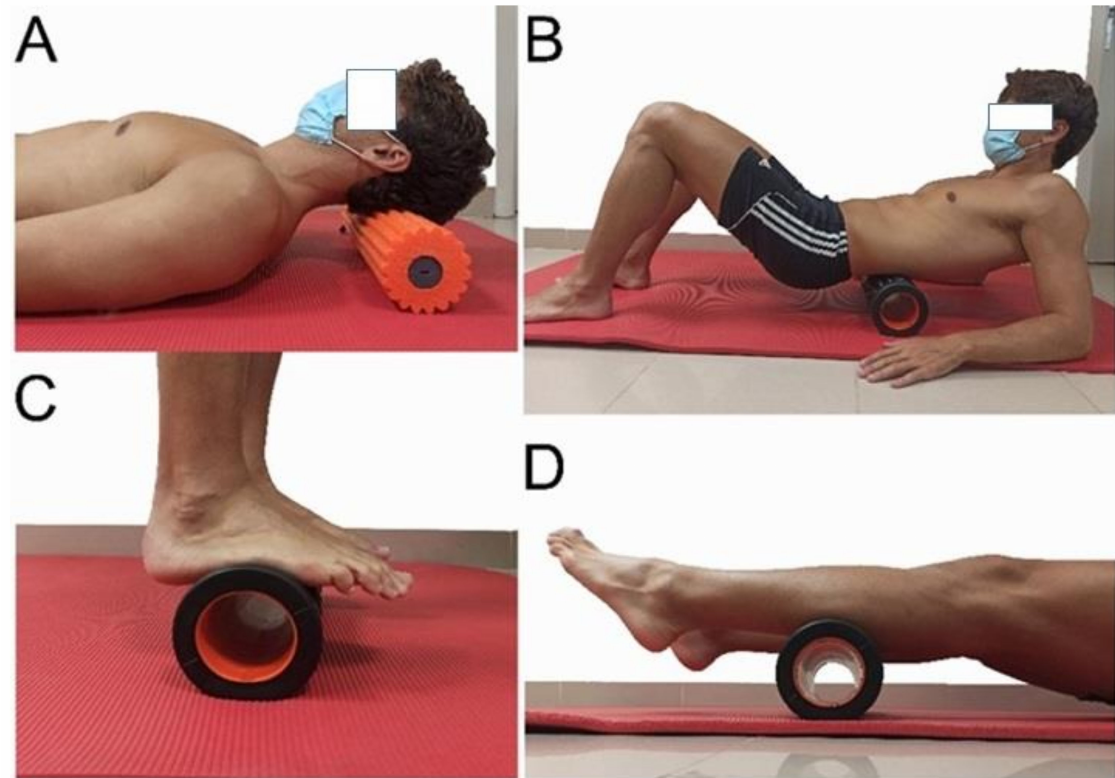
Figure 2. Interventions. ( A ) intervention to the epicranial aponeurosis, ( B ) thoracolumbar facia and erector muscles intervention, ( C ) plantar fascia and ( D ) posterior part of the sural